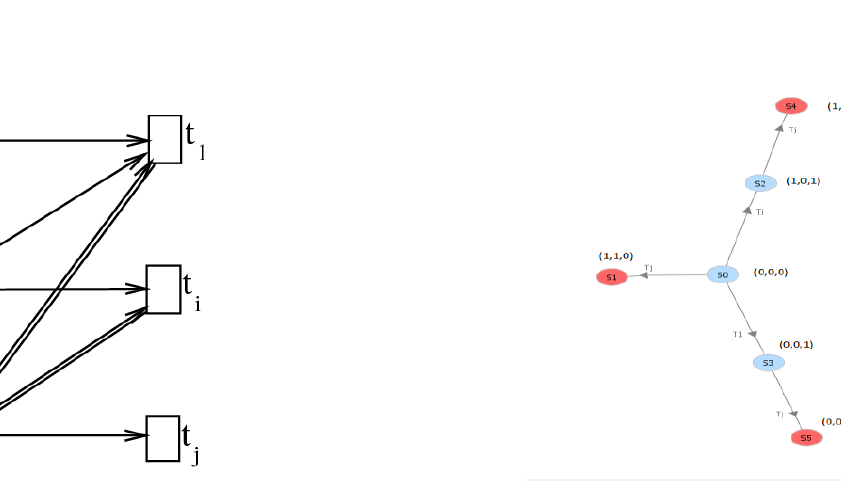
Figure 7. Petri net containing subnet-3 and its coverability